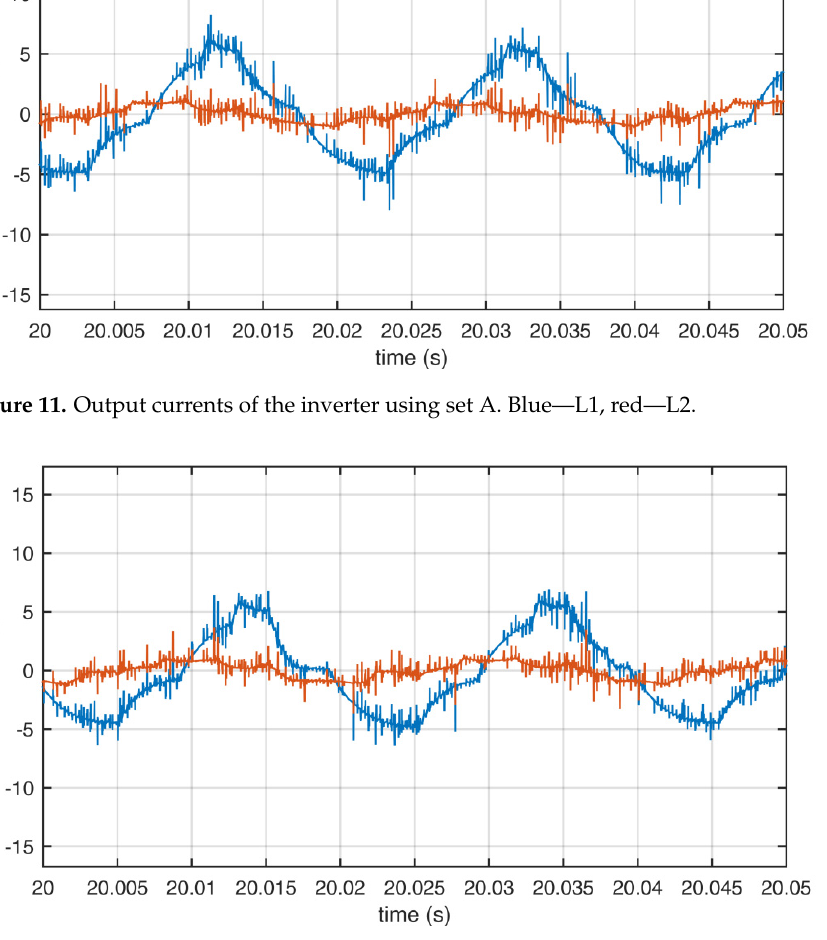
Figure 12. Output currents of the inverter using set B. Blue—L1, red—L2.